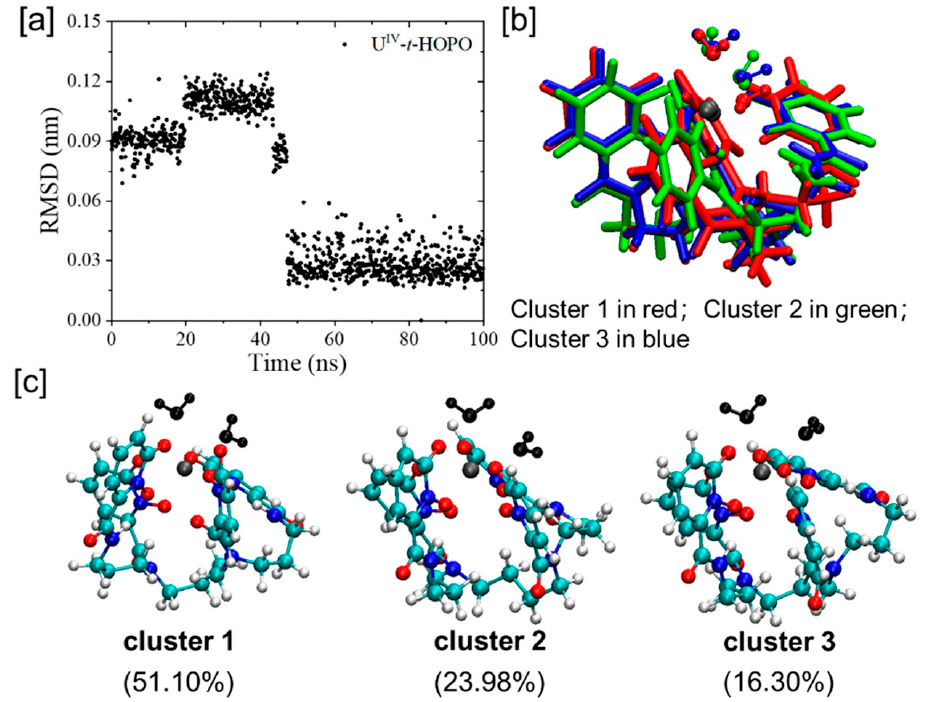
Figure 12. ( a ) Atomic positional RMSD of all atoms of U IV ( κ 8 - t -HOPO) complex with the central structure of cluster 1 used as the reference. ( b ) The superposition of the central structures of the top three clusters (colored in red, green and blue according to their ranks) in the simulations of U IV ( κ 8 - t -HOPO) complex. The cutoff for clustering analysis is 0.05 nm. ( c ) The central structures of the top three clusters in the simulations of U IV ( κ 8 - t -HOPO) complex. Color scheme: N atoms in blue, O atoms in red, water molecules in black, C atoms in cyan, H atoms in white, and U atom in brown. The time evolution of RMSD with the starting structure as the reference was also calculated and is provided in the Supporting Information (Figure S6).